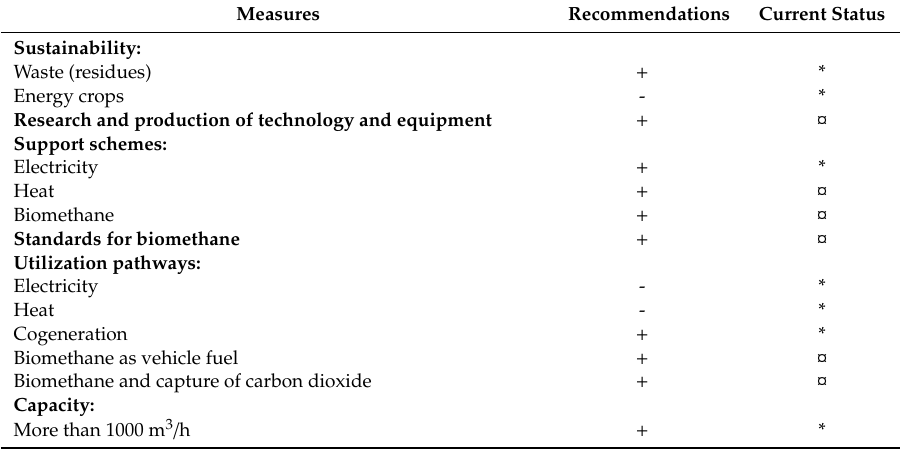
Table 5. Recommendations and current